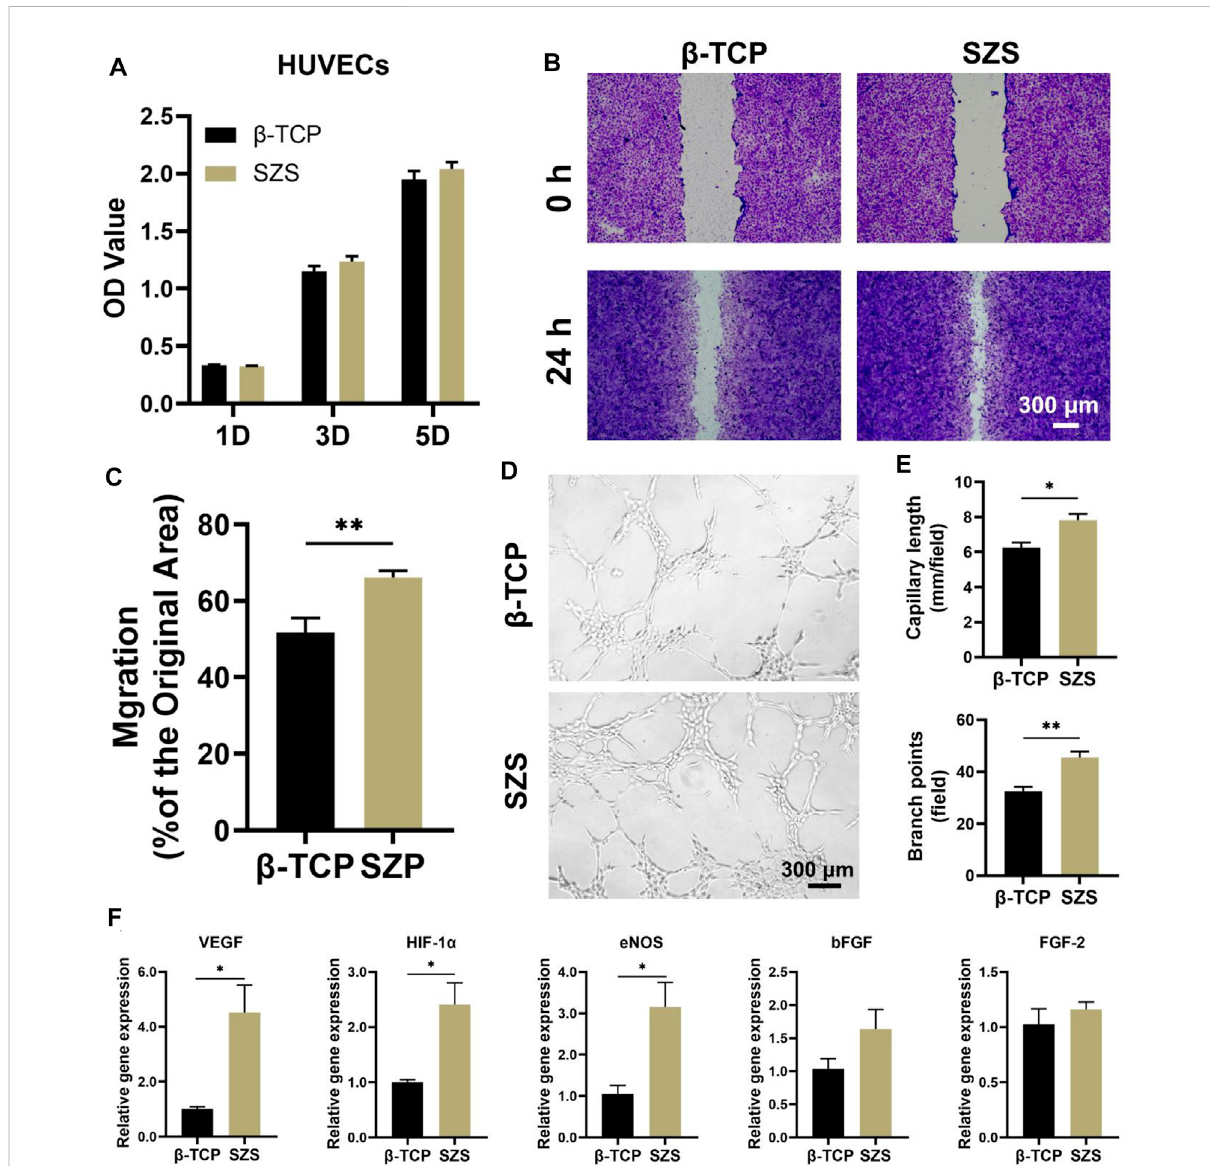
FIGURE 5 Effectofmacrophage/scaffoldconditionalmediumonHUVECs. (A) Cellproliferationonday1,3,and5.( n =6). (B) Representativeimagesofcell migration after 1 day ’ s culture. (C) Quantitative analysis of cell migration rate. ( n = 8 for β -TCP; n = 9 for SZS). (D) Representative images and (E) quantitative analysis of the in vitro tube formation. ( n = 4). (F) The angiogenic genes (VEGF, HIF-1 α , eNOS, bFGF and FGF-2) expression in cells by q-PCR assessment after 3 days ’ s culture. ( n = 4). * p < 0.05; ** p <